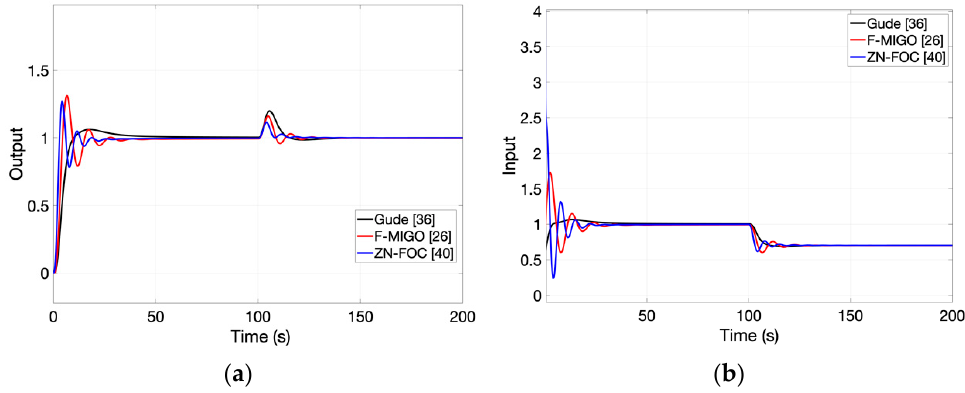
Figure 12. ( a ) Output signals for FO-PID control of higher order process ( b ) Input signals for FO-PID control of higher order process (controllers tuned according to [26,36,40]).